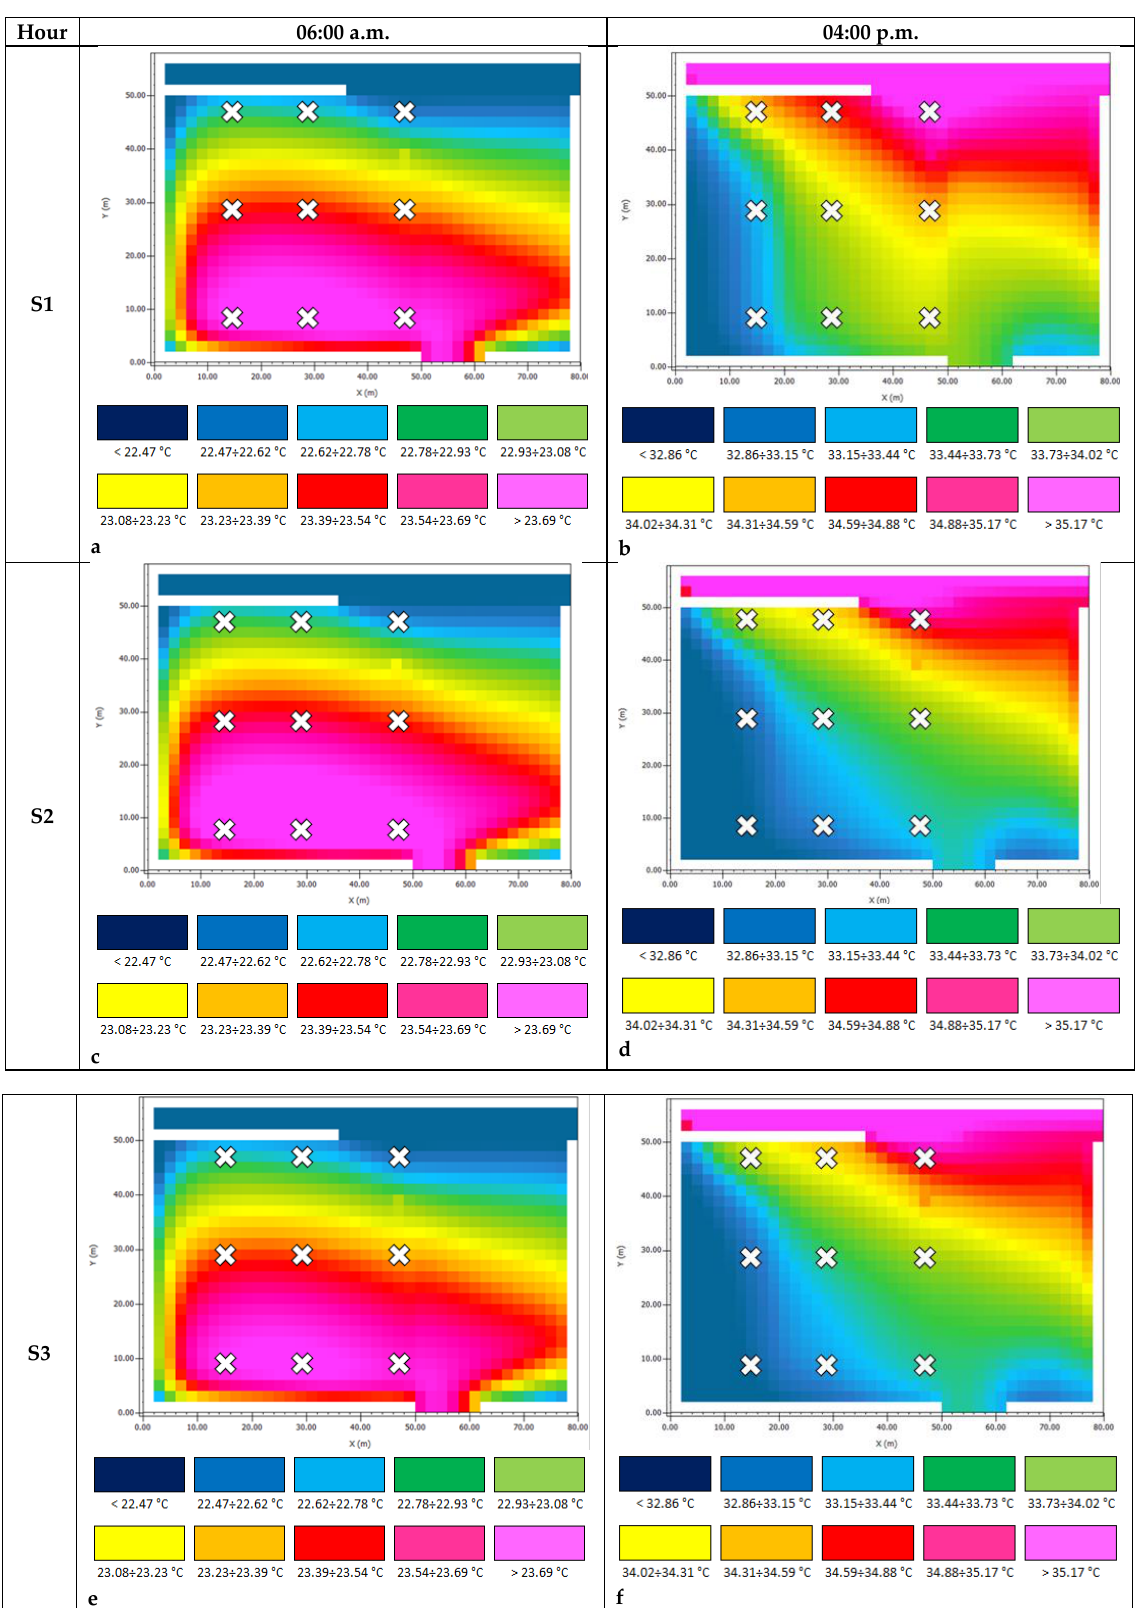
Figure 16a–f and Figure 17a–f show the AT and PMV chromatic output maps, respec- tively; the red crosses are the positions of Pi.